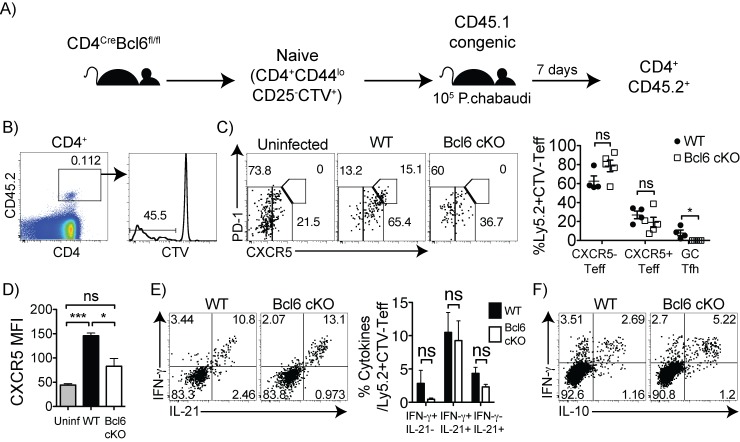
Bcl6 controls generation of GC Tfh, but not cytokine profile, in responding effector cells.(A) Naïve (CD44loCD25-) CD4 T cells (2x106) from either Bcl6fl/fl CD4Cre (Bcl6 cKO) or Bcl6fl/fl (WT) were labeled with cell trace violet (CTV) and adoptively transferred into Ly5.1 (CD45.1) congenic mice, followed by P. chabaudi infection. On day 7 post-infection, splenocytes were harvested and stained with (B) CD4, CD45.2, CTV, (C, D) PD-1, CXCR5, (E) IFN-γ, IL-21, and (F) IFN-γ, IL-10. (B) Plots showing the gating on responding CD4+CD45.2+CTV- T cells. (C) Graph shows percentages for individual recipients of effector T cell subsets. No CD45.2+ CXCR5hiPD-1hi GC Tfh cells were detected in any recipient of Bcl6 cKO T cells. (D) Bar graph shows CXCR5 MFI of CD4+CD45.2+CTV- donor cells. (E) Plots and bar graph of average IFN-γ and IL-21 cytokine producers in the responding donor cells (CD45.2+CTV-) in recipients of WT and Bcl6 cKO T cells. (F) Dot plot showing intracellular cytokine staining. Data are representative of three independent experiments with 4–5 animals per group. Numbers within plots represent mean percentages. Statistical significance was obtained using Students t-test. Error bars represent the SEM; ★
p < 0.05, ★★★
p < 0.001, ns = not significant.